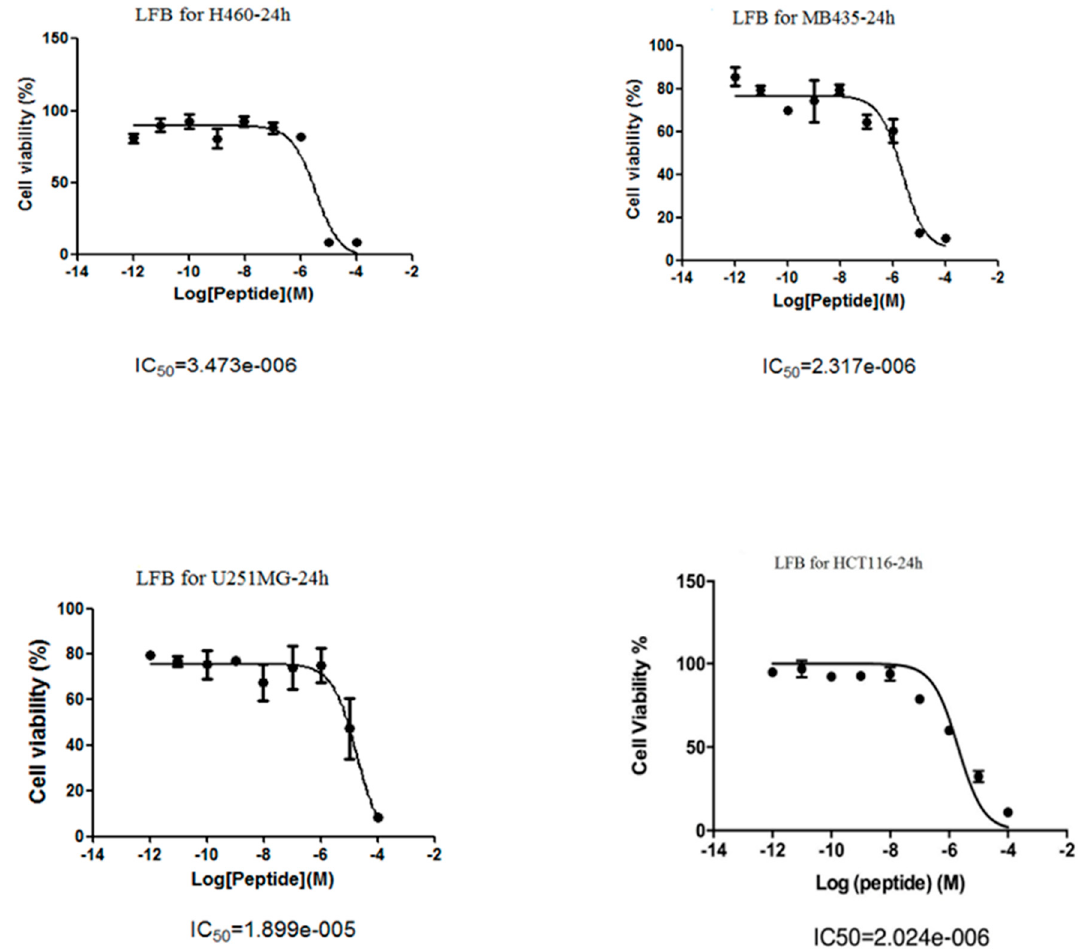
Figure 3. Anti-proliferative effects of LFB on a panel of human cancer cell lines after 24 h incubation. Panels illustrate the effect on NCI-H460 (human non-small cell lung cancer cell line), H838MDA-MB-435S (human breast cancer cell line), U251MG (human neuronal glioblastoma cell line), HCT116 (human colon cancer cell) respectively. IC 50 values were given for each peptide in panels below graphs.